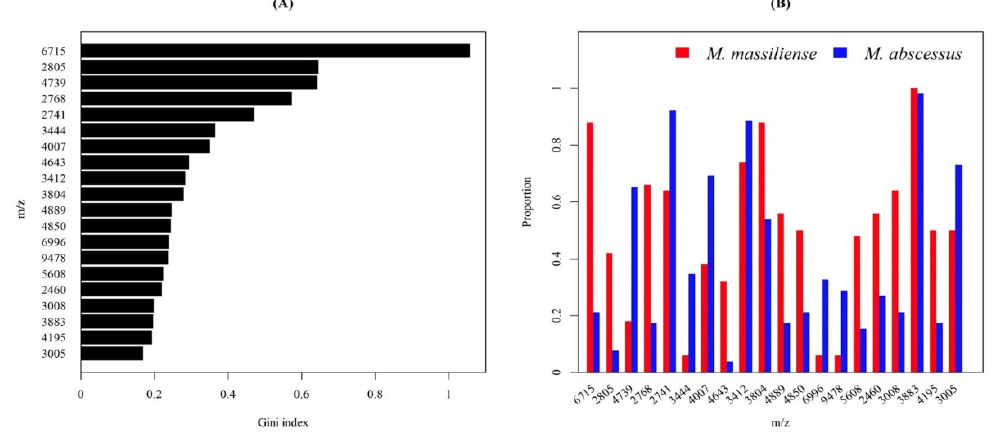
Figure 9. Informative peaks. ( A ) Informative peaks are sorted by RF importance. ( B ) The occurring frequency of the informative peaks amid the two MABC subspecies. frequency of the informative peaks amid the two MABC